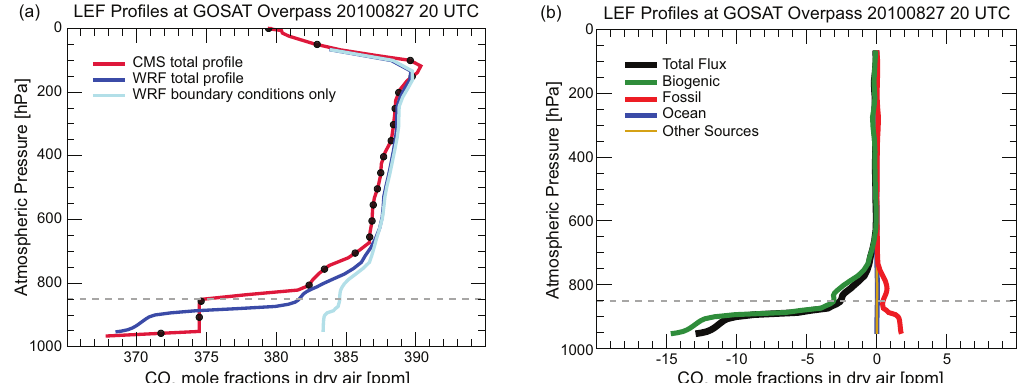
Figure 6. Profiles of modeled distribution of CO 2 within a column at the LEF tall tower in northern Wisconsin, USA, at the time of a GOSAT overpass on 27 August 2010. ( a ) Total CO 2 from the CMS-optimized mole fractions and the WRF simulation. Black dots on the CMS profile indicate the 20 pressure levels from the ACOS GOSAT a priori profile. The light blue profile is the transported boundary condition tracer from the WRF simulation. ( b ) Profiles of the flux tracers from the WRF simulation. The total of the flux tracers and transported boundary conditions equals the total WRF profile. Other sources include biomass burning, biofuel burning and ship bunker fuel emissions. The dashed line marks the separation of the profiles into lower and upper